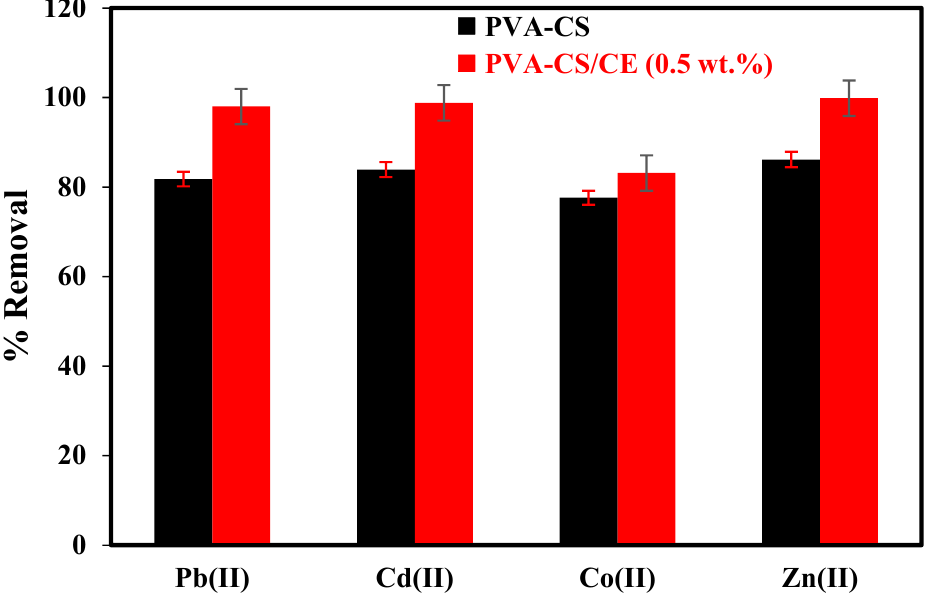
Figure 2. Effect of CE content (0, and 0.5 wt.%) on percent removal of Pb(II), Cd(II), Co(II), and Zn(II) at hydrogel beads (C 0 [heavy metals] = 50 mg/L, volume = 50 mL, pH (Pb and Cd) = 6, pH (Co and Zn) = 8, bead dose = 0.5 g, time = 200 min, temperature = 30 °C).